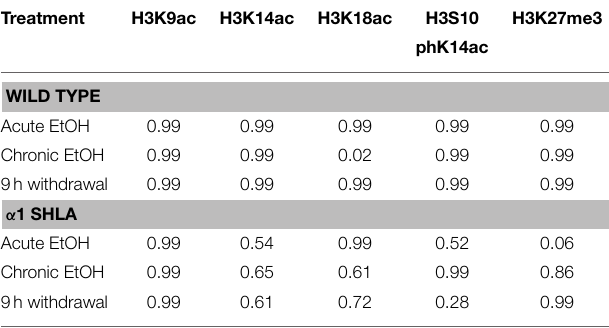
TABLE 4 | Summary of Bonferroni post-hoc tests for Experiment